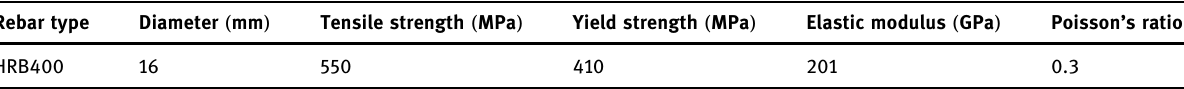
Table 2: Basic performance indicators of rebar